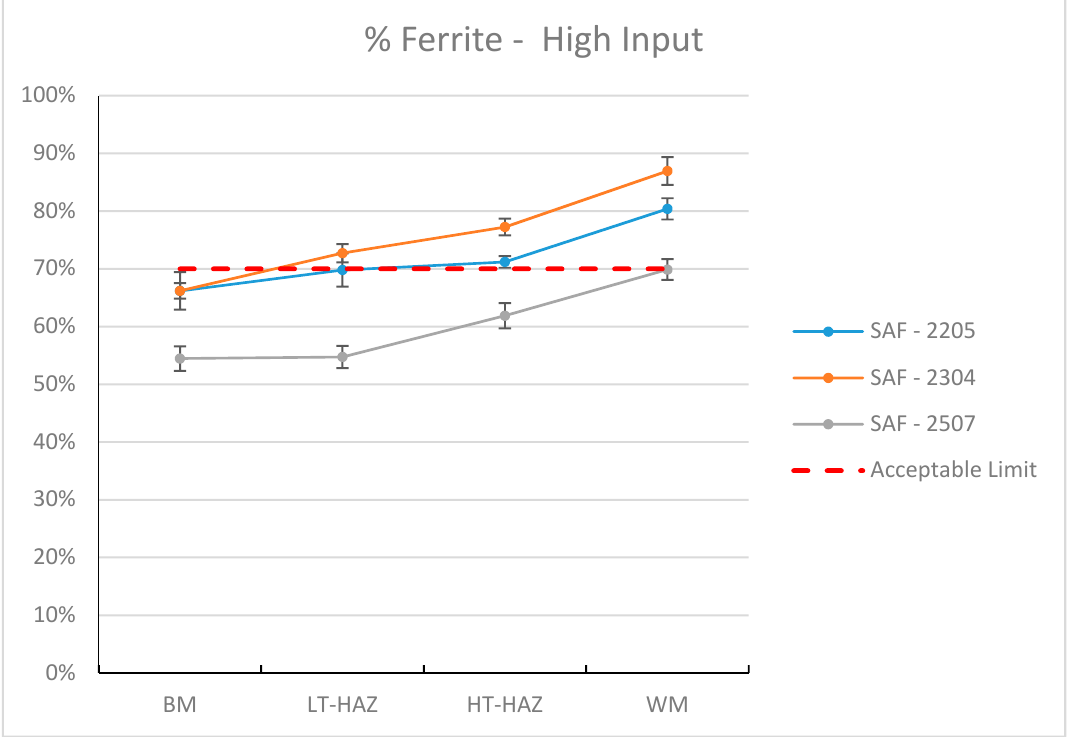
Figure 11. Volumetric Fraction of ferrite—High Input: BM; LT-HAZ; HT-HAZ; WM.